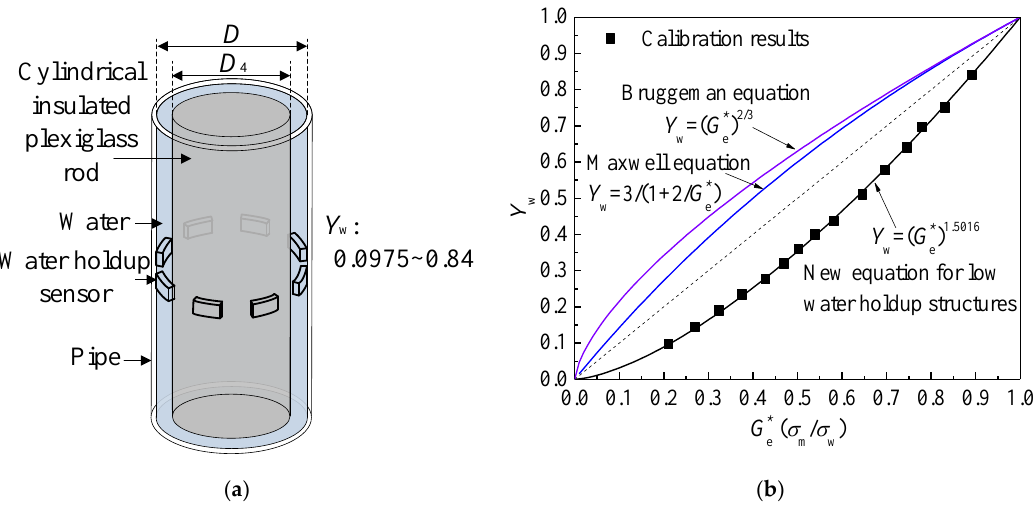
Figure 9. Establishment of the water holdup measurement model for low water holdup structures: ( a ) Calibration device; ( b ) Model establishment.